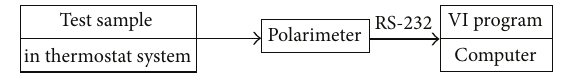
Figure 1: The structure diagram of the